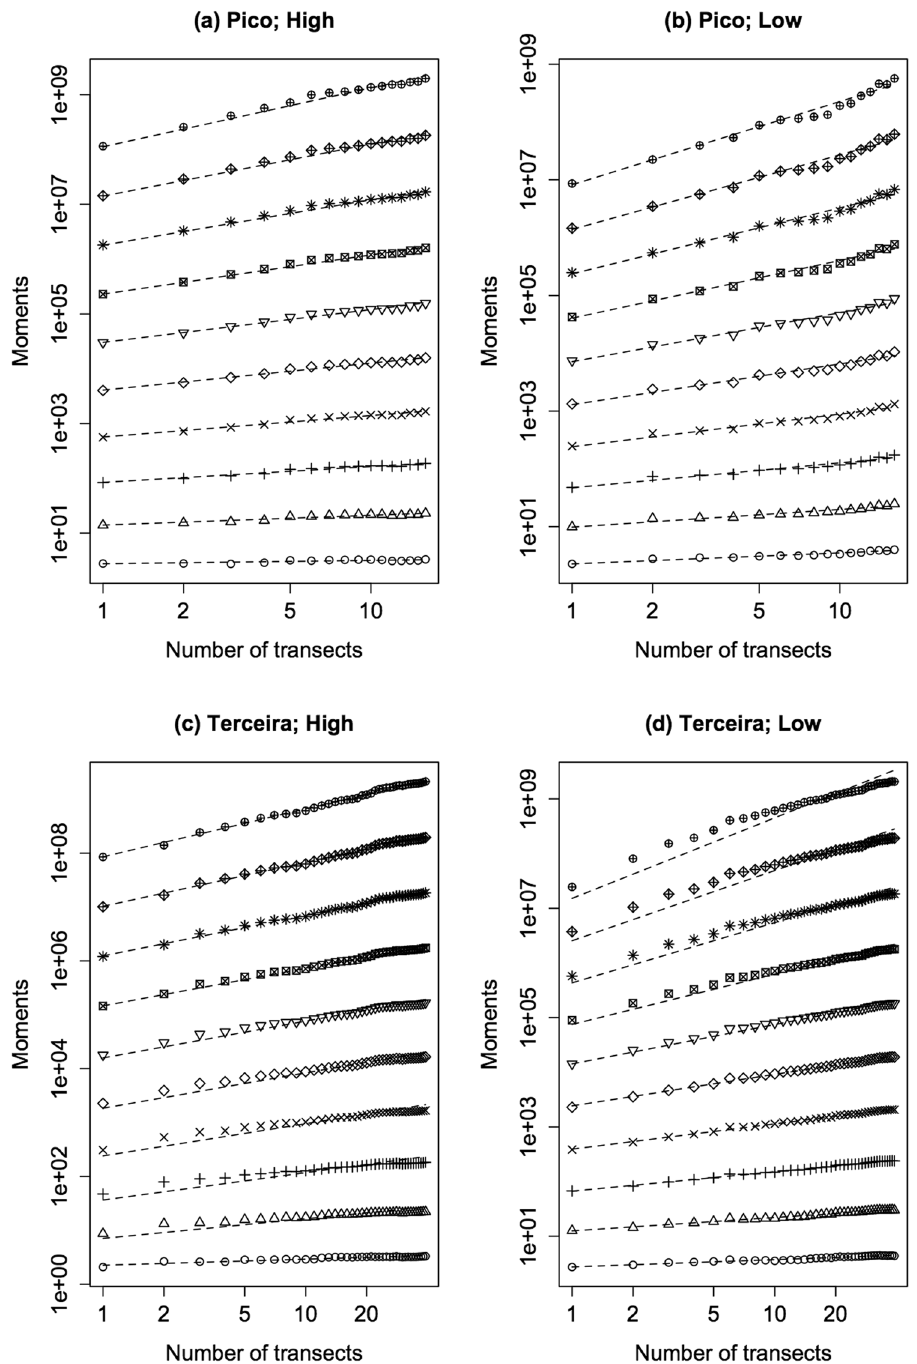
Figure 5. Double logarithmic plots of the first 10 integer moments as a function of the number of transects. Plots a and c correspond to high dispersal ability and panels b and d to low dispersal ability arthropod species of Pico and Terceira islands. In both cases the sequence of added transects was that obtained by using the concentric procedure, as explained in Methods. The order of the moments increases from the bottom to the top lines. Notice that these plots correspond to one sequence of added transects. The dashed lines were obtained from linear regression of the logarithmic transformed value of the